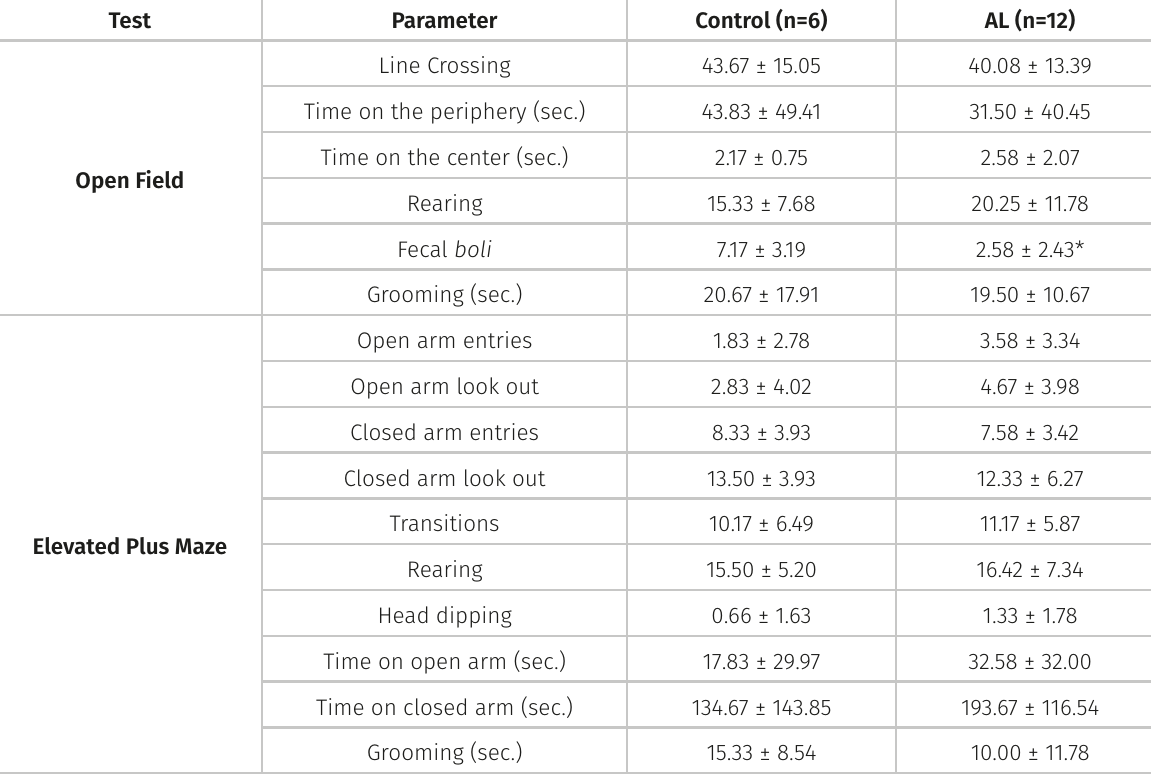
Table I. Parameters analyzed by the Open Field test and Elevated Plus Maze, in Control (CO) and Alcohol (AL)